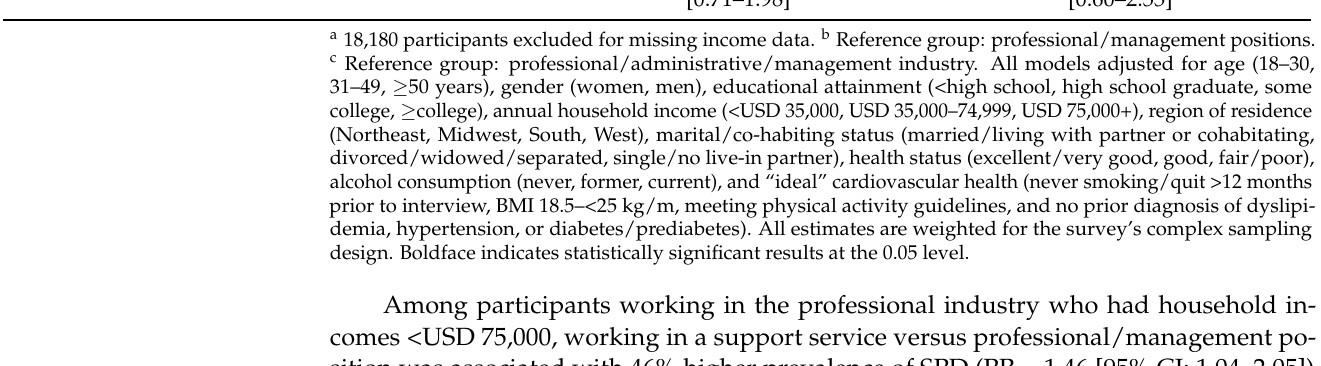
(Table 5). Household income-race/ethnicity-stratified associations for occupational